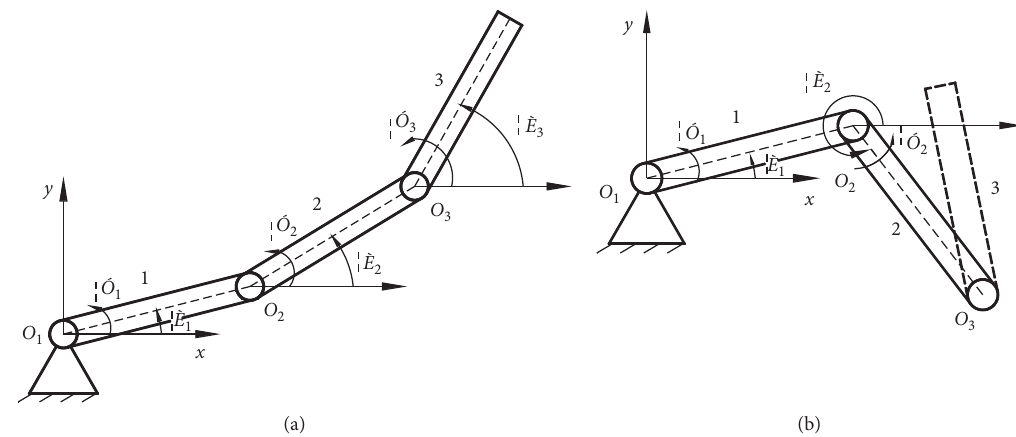
Figure 4: The open-loop three-bar constrained metamorphic mechanism. (a) Configuration 1. (b) Configuration 2.